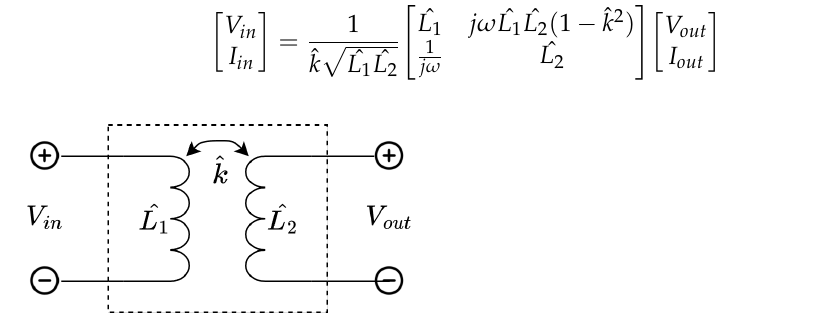
Figure 4. Circuit used for two-port modeling of a single